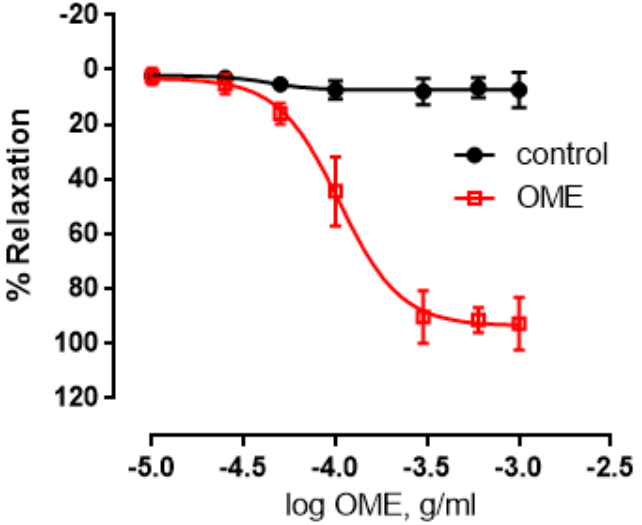
Figure 1. E ff ect of Origanum majorana (OME) extract on the vasorelaxation of aortic rings. Cumulative dose response curve for OME-induced relaxation of rat aortic rings was determined. Data expressed are mean ± standard error of the mean (SEM, n = 7).